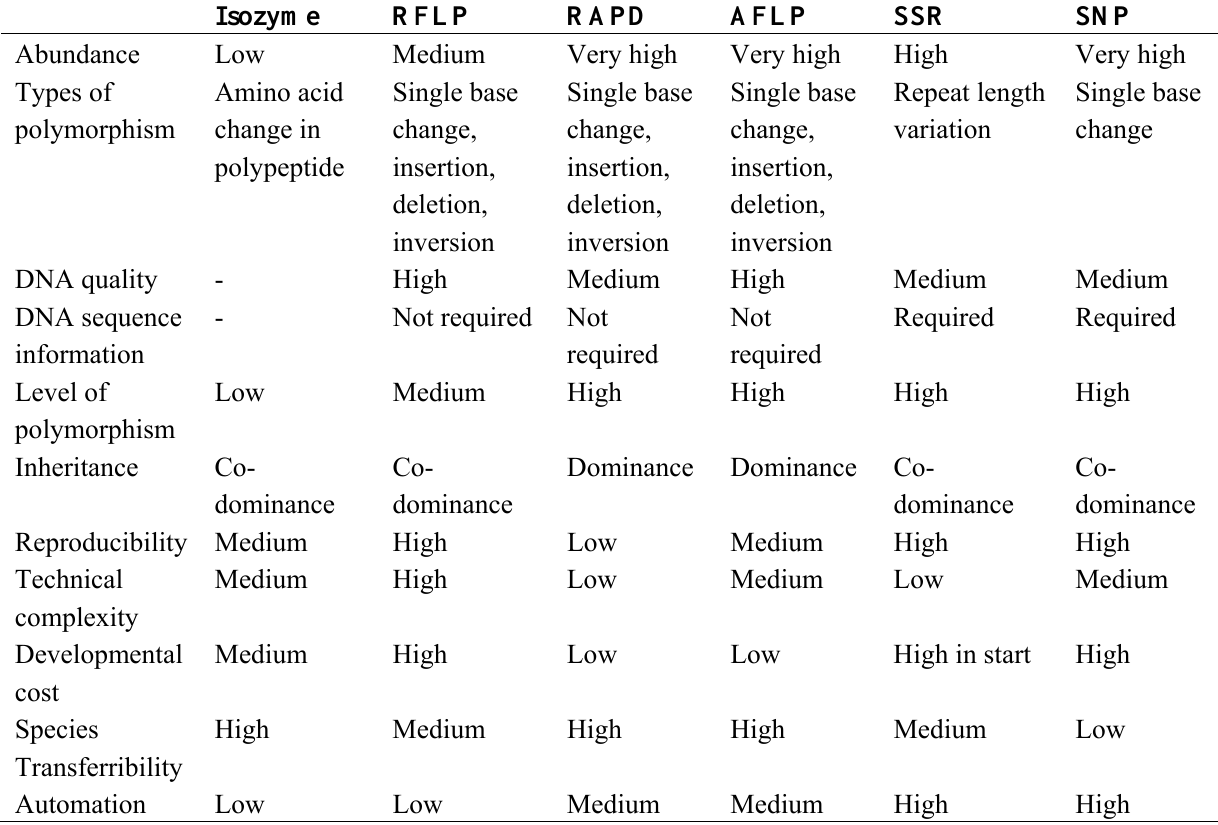
Table 1. Comparison of widely using molecular marker systems for plant genome